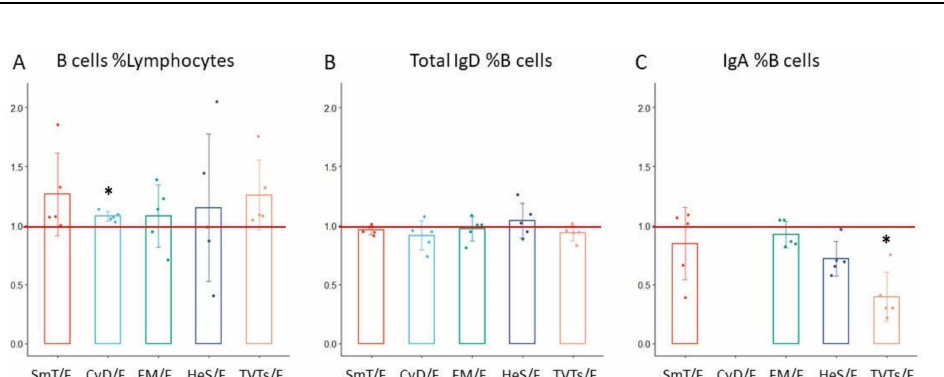
Figure 2. Comparison of B-cell subsets using the five cryopreservation methods assessed. The cell frequency variation in thawed (T) with respect to fresh (F) sample (represented as T/F ratio) is shown for each cryopreservation method. The red line indicates the ideal ratio of 1, meaning no cell frequency variation between cryopreserved and fresh whole blood. The variation of ( A ) B cells, ( B ) IgD positive B-cells and ( C ) IgA positive B-cells were represented as mean values of 5 samples ± standard deviation. * p -values from the paired t -test <